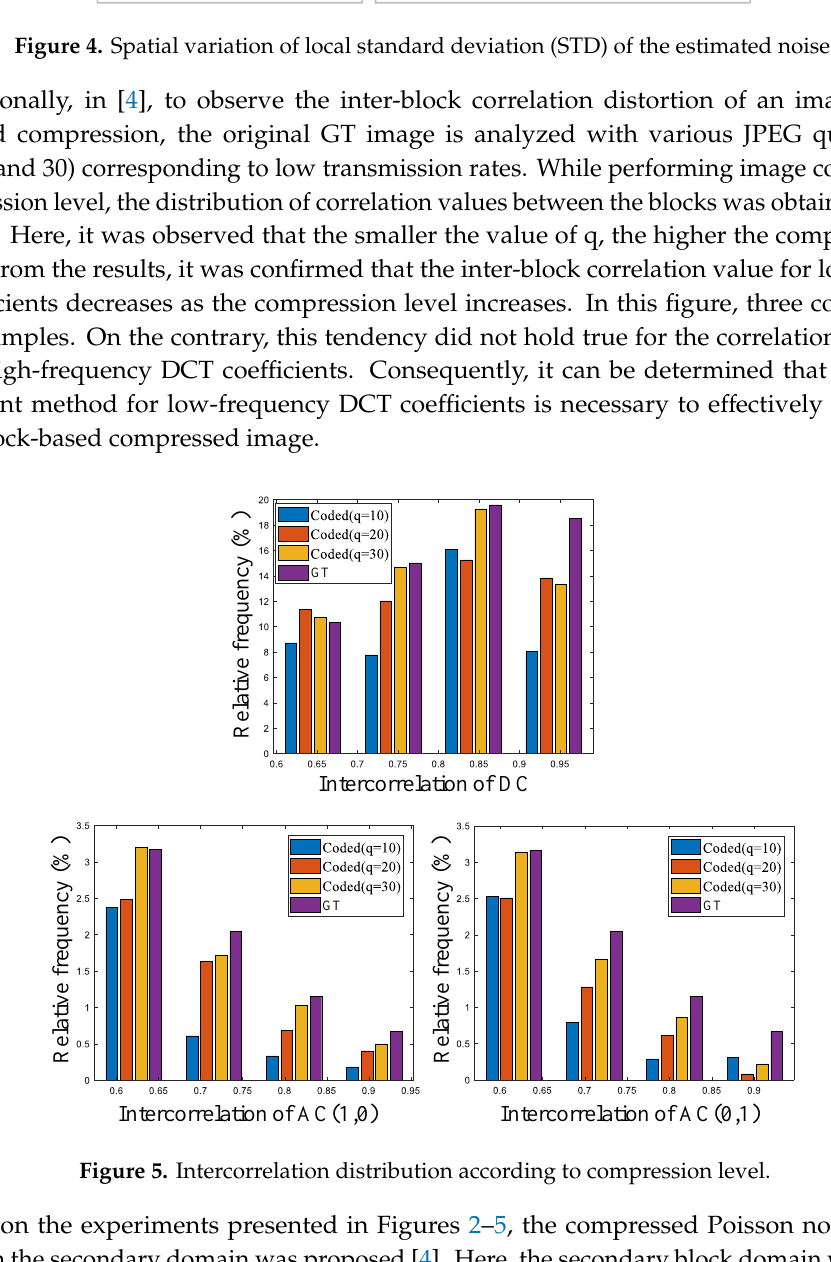
block-based compression, the original GT image is analyzed with various JPEG quality factors ( q =